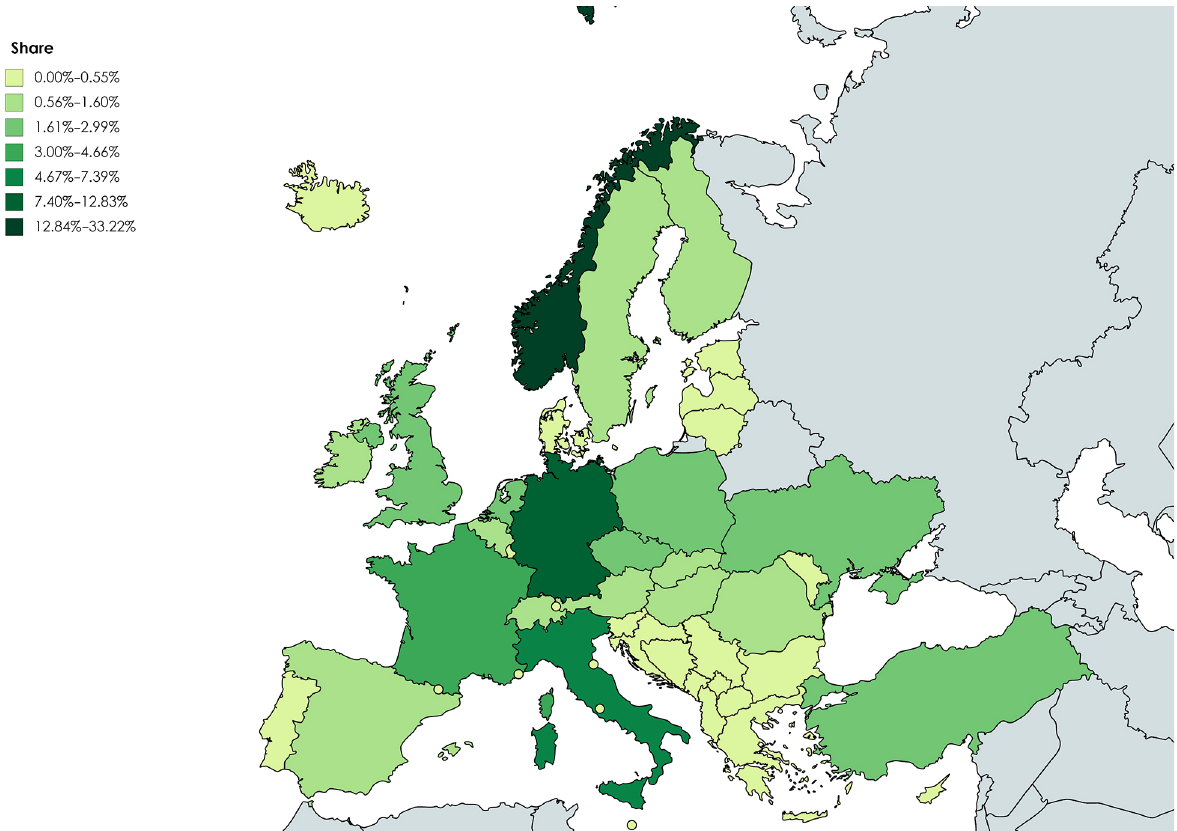
Fig. 7. Geographical structure of the EAEU merchandise imports from Europe in 2018. Source: own study based on the Eurasian Economic commission